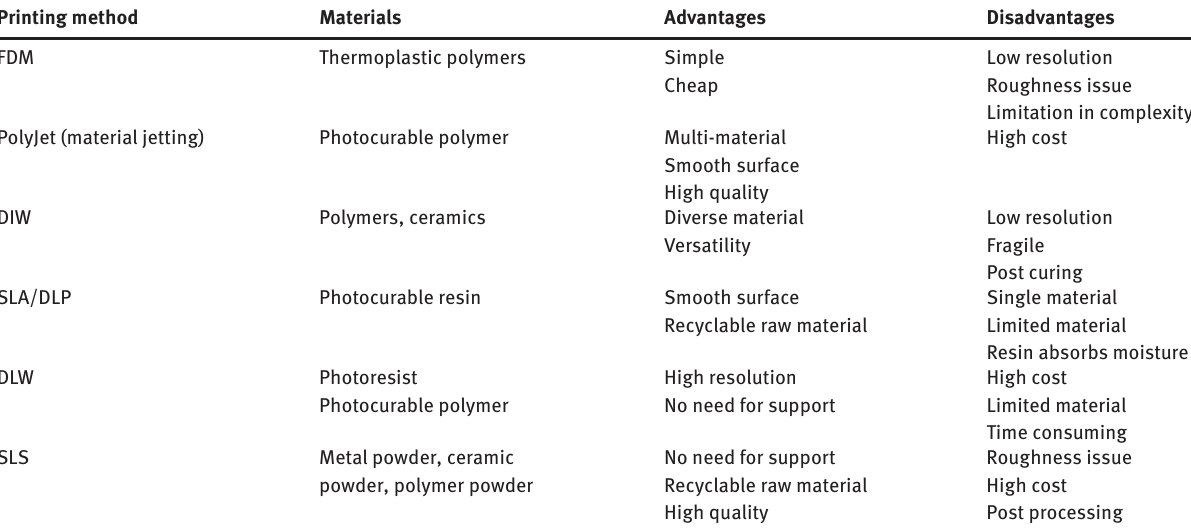
Table 1: Comparison of 3D printing methods. Printing